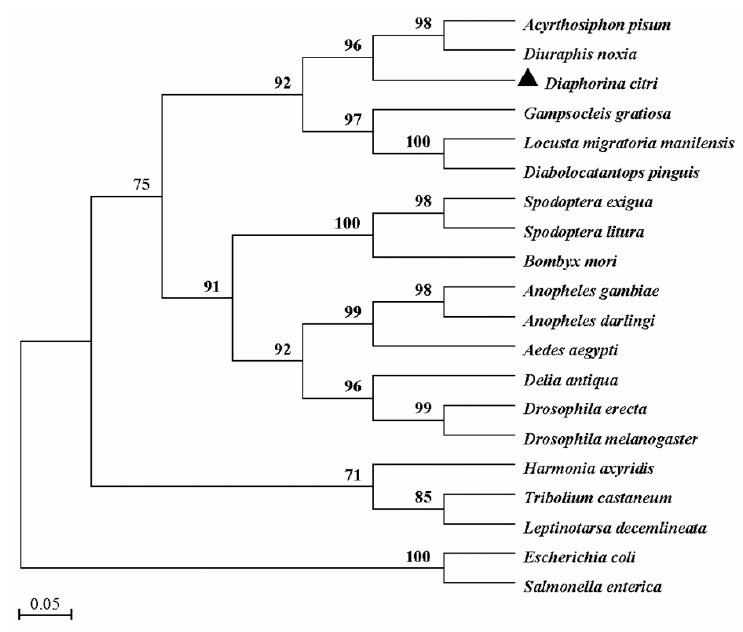
Figure 3. Phylogenetic analysis of DcTPS and TPSs from other species. The phylogenetic tree was constructed based on the amino acid sequences of known TPSs. Full-length amino acid sequences were aligned with the Mega 7.0 program to generate the phylogenetic tree by the maximum likelihood method. A bootstrap analysis was carried out, and the robustness of each cluster was verified with 1000 replicates. Values at the cluster branches indicate the results of the bootstrap analysis. The sequences were obtained from GenBank under the following accession numbers: Acyrthosiphon pisum